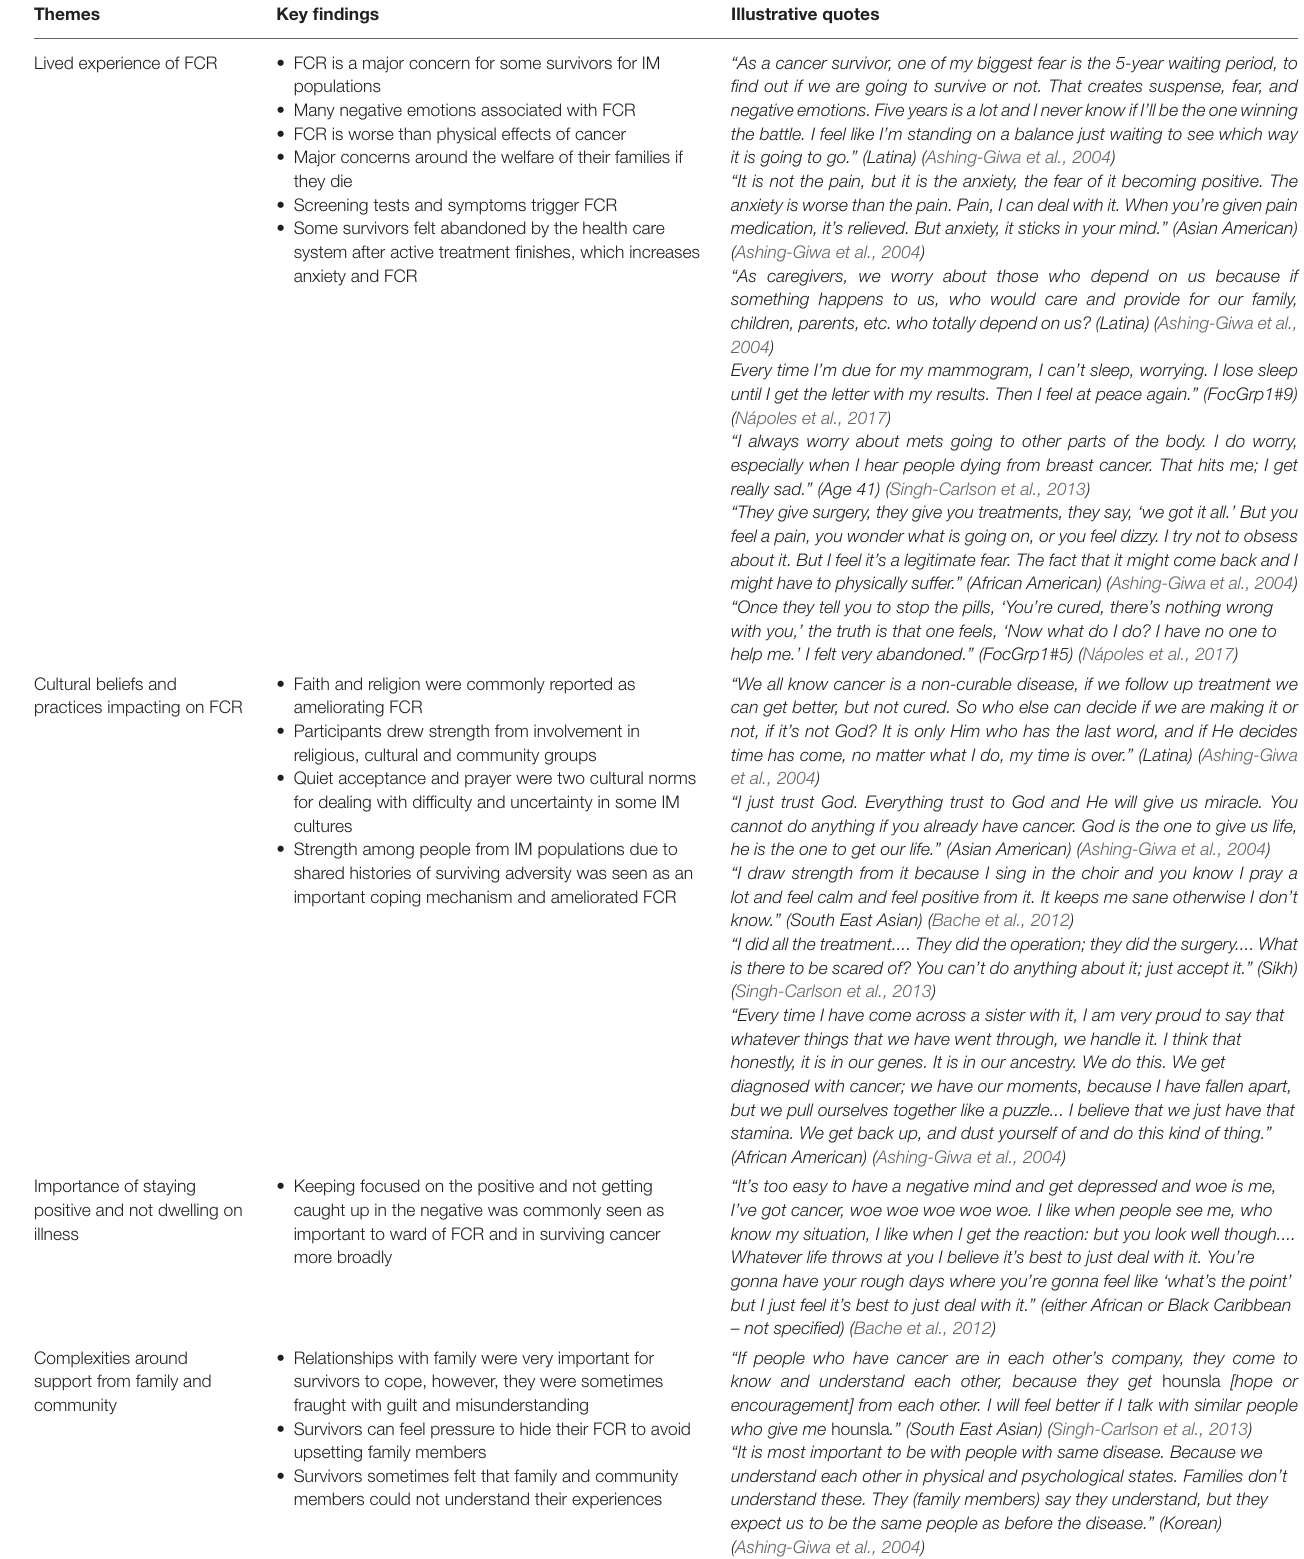
TABLE 4 | Summary of main themes identified via meta-aggregation of qualitative studies.